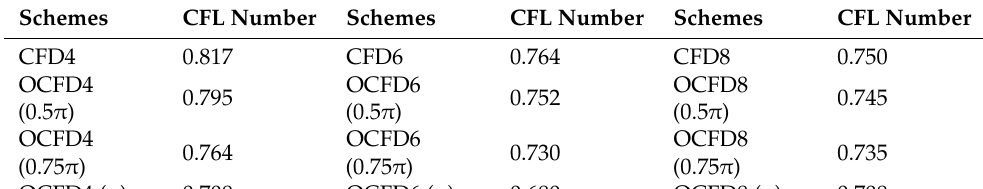
Table 3. CFL number of the CFD and OCFD schemes.